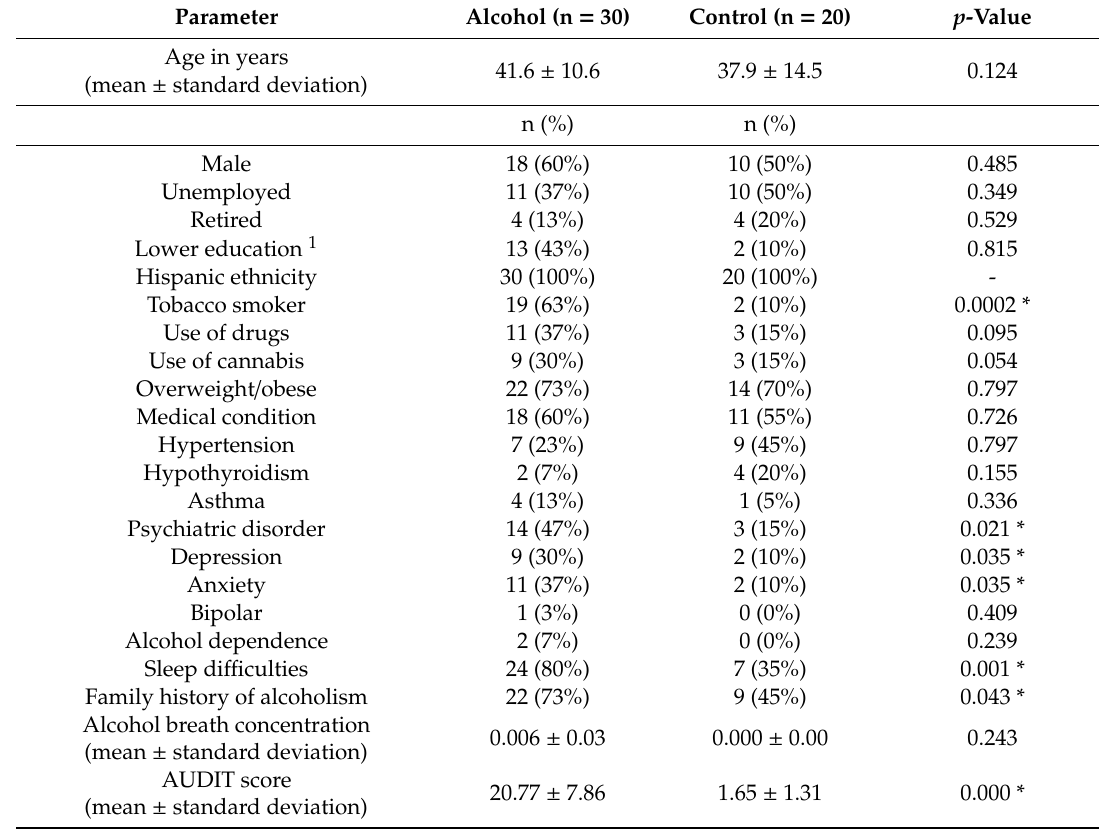
Table 1. Socio-demographic and clinical characteristics of study